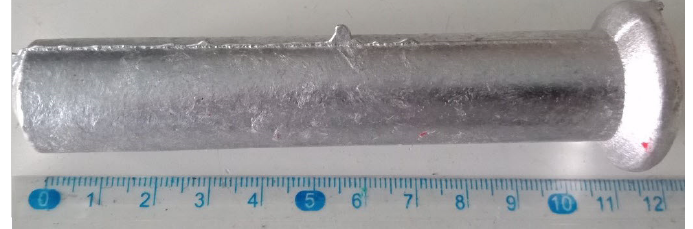
Figure 1. The consumable rod of the as-cast Al-Si before the machining process. The chemical composition of the as-cast A356 was investigated using Foundry-Master pro, (Oxford Instruments, Abingdon, UK). Table 1 lists the chemical composition of the as-cast A356 alloy. It can be seen that the major alloying elements in the Al base are Si, Cu, and Fe, with traces of other elements including Zn, Mg, Sn, and Mn. Figure 2 illustrates part of the Al-Si binary phase diagram showing the A365